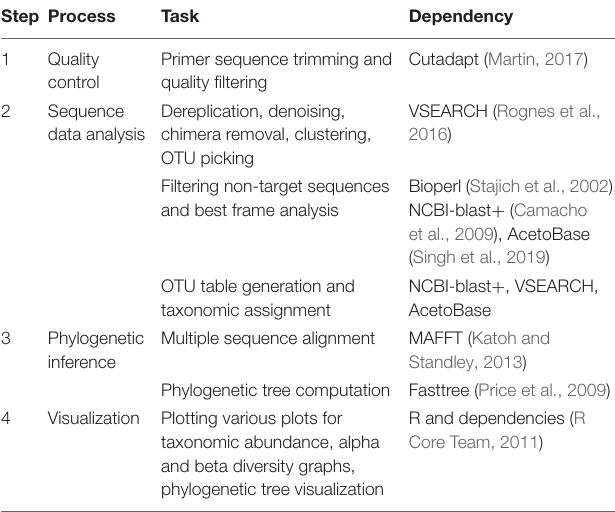
TABLE 1 | Overview of the AcetoScan analysis